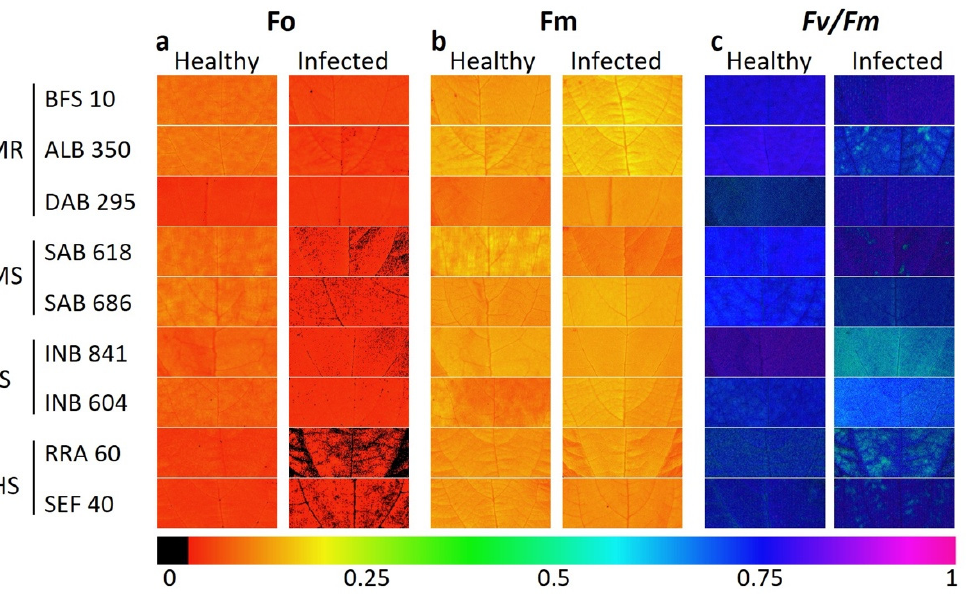
Figure 6. Images of chlorophyll fluorescence parameters of different advanced lines of common beans under two leaf conditions (healthy and infected). BSF 10, ALB 350, DAB 295: moderately resistant (MR). SAB 618, SAB 686: moderately susceptible (MS). INB 841 and INB 604: susceptible (S). RRA 60 and SEF 40: highly susceptible (HS). ( a ) Initial fluorescence (F o ); ( b ) maximum fluorescence (F m ); ( c ) maximum quantum efficiency of PSII (F v /F m ). The change in the color gradient from violet to red signifies a change in value from higher to lower for each variable.